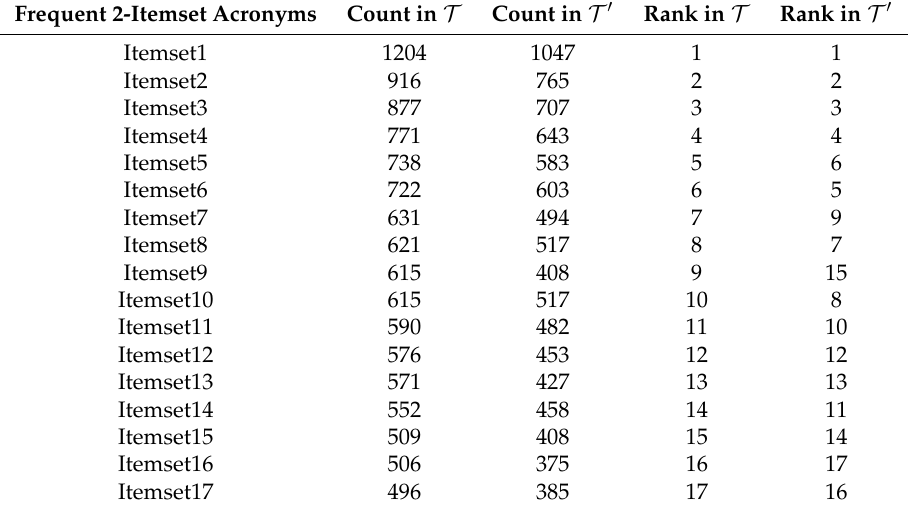
Table 5. Frequent two-itemsets (minimum support =